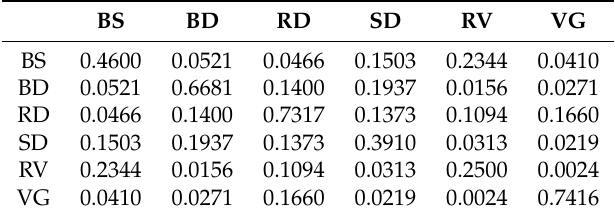
Table 4. Co-occurrence matrix of Beijing dataset. Bare soil: BS, Buildings: BD, Road: RD, Shadow: SD, River: RV, Vegetation: